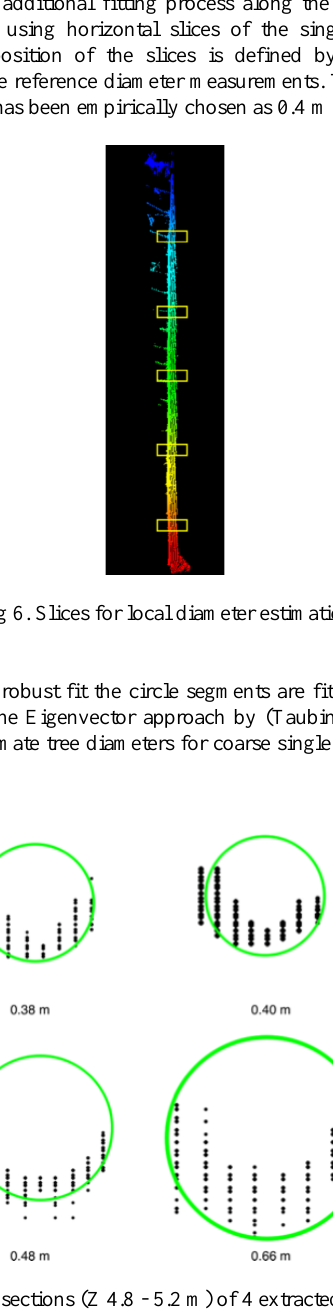
Fig 7. Cross sections (Z 4.8 - 5.2 m) of 4 extracted tree clouds (black) with fitted tree diameters